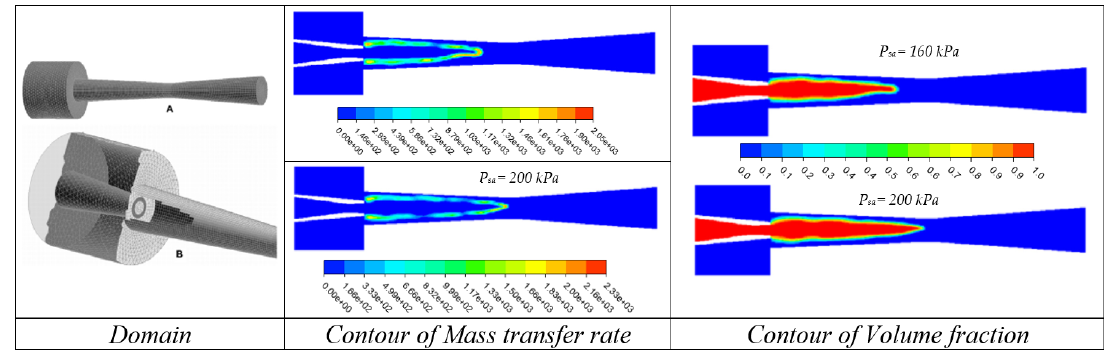
Figure 28. Condensation of steam in central steam jet-water ejector [91].